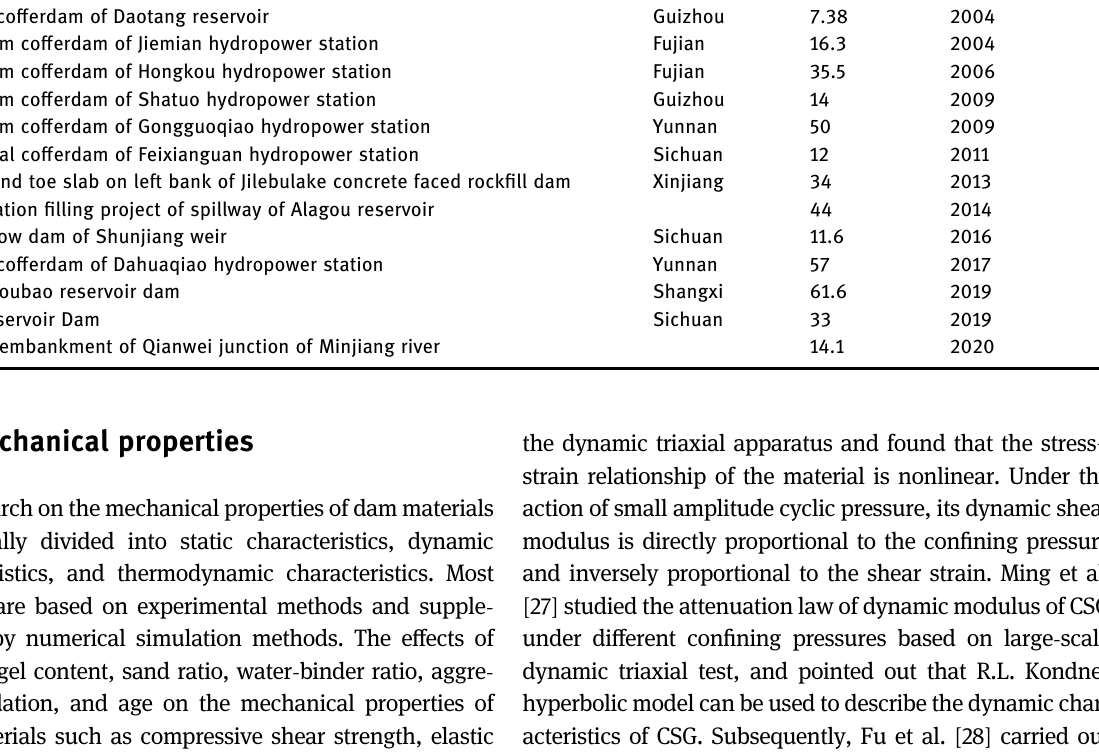
Table 2: Domestic cementing sand and gravel engineering Project